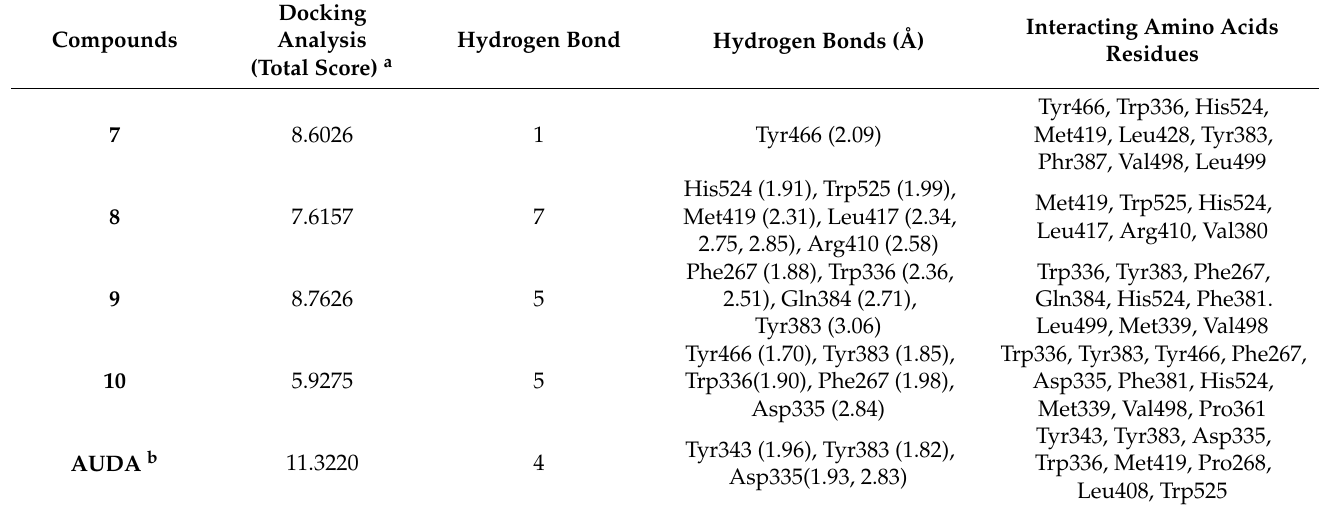
Figure 3. Molecular docking of compounds 7 – 10 with sEH (the green dotted lines are hydrogen bonds). Table 2. Inhibitory activity of compounds 1 – 10 on